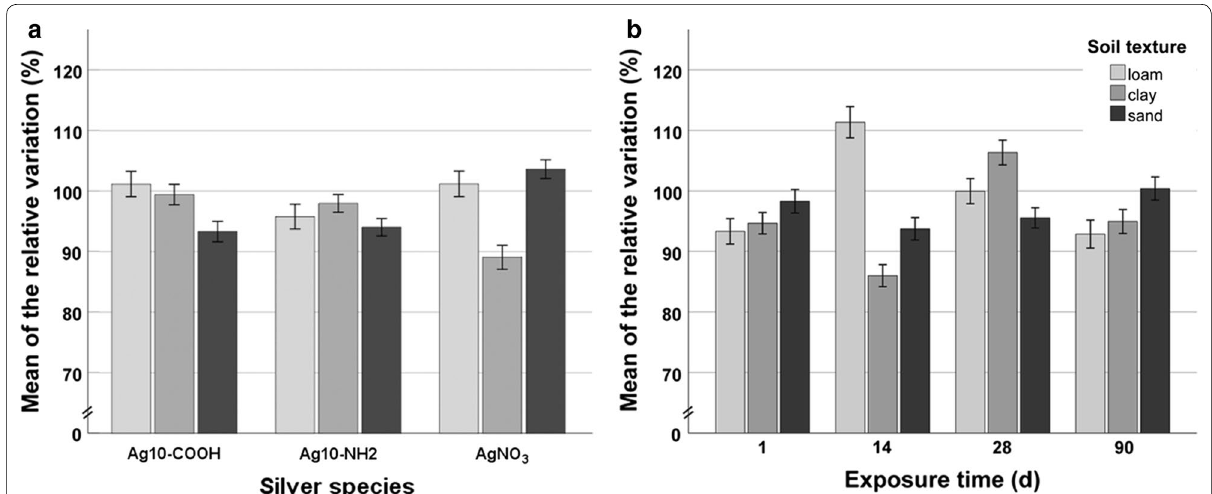
Fig. 4 Impact of factor combinations on the entirety of the relative variation of the biological parameters. a Silver species soil texture , b exposure × time soil texture . The error bars represent the 95% confidence interval. N 4320. The relative variations (%) were set as dependent variable. The × = factors were set as independent variable. To calculate the impact of the factor combination silver specie s soil texture on the relative variation of the × biological parameters, the relative variations were unconnected to the factors concentration and exposure time ( a ). To calculate the impact of the factor combination exposure time soil texture on the relative variation of the biological parameters, the relative variations were unconnected to the × factors concentration and silver species ( b